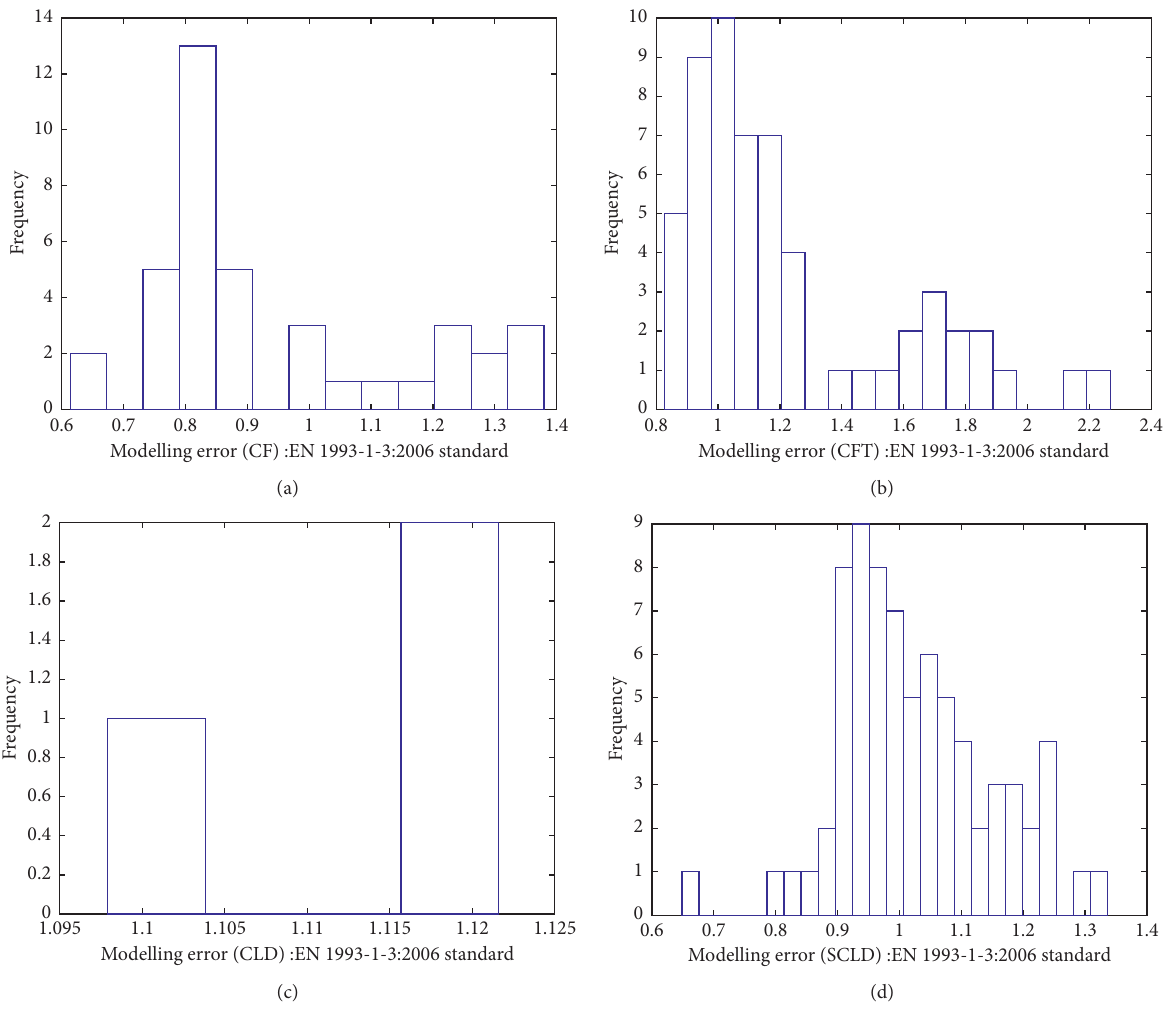
Figure 8: ME histograms for various failure modes for database member as per EN 1993-1-3:2006 Standard. (a) CF—column flexure; (b) CFT—column flexure-torsion; (c) CLD—column local and distortion buckling; (d) SCLD—stub column local and distortional buckling. Table 7: Results of Chi-square goodness-of-fit test for modelling error of test database compression members. Design